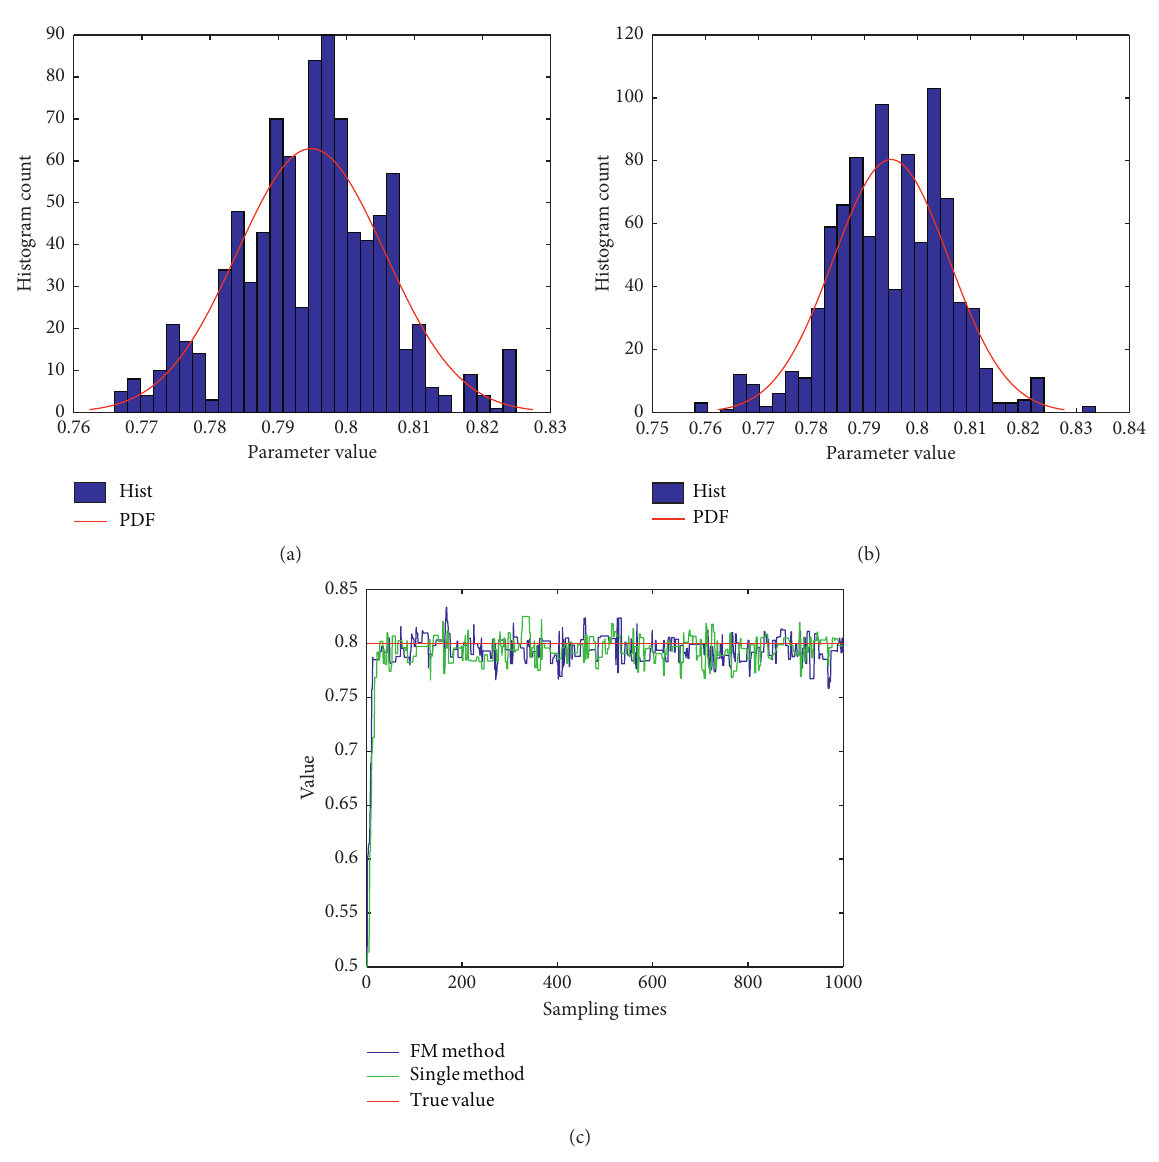
Figure 4: Case study 1: (a) single method, (b) FM method, and (c) sampling